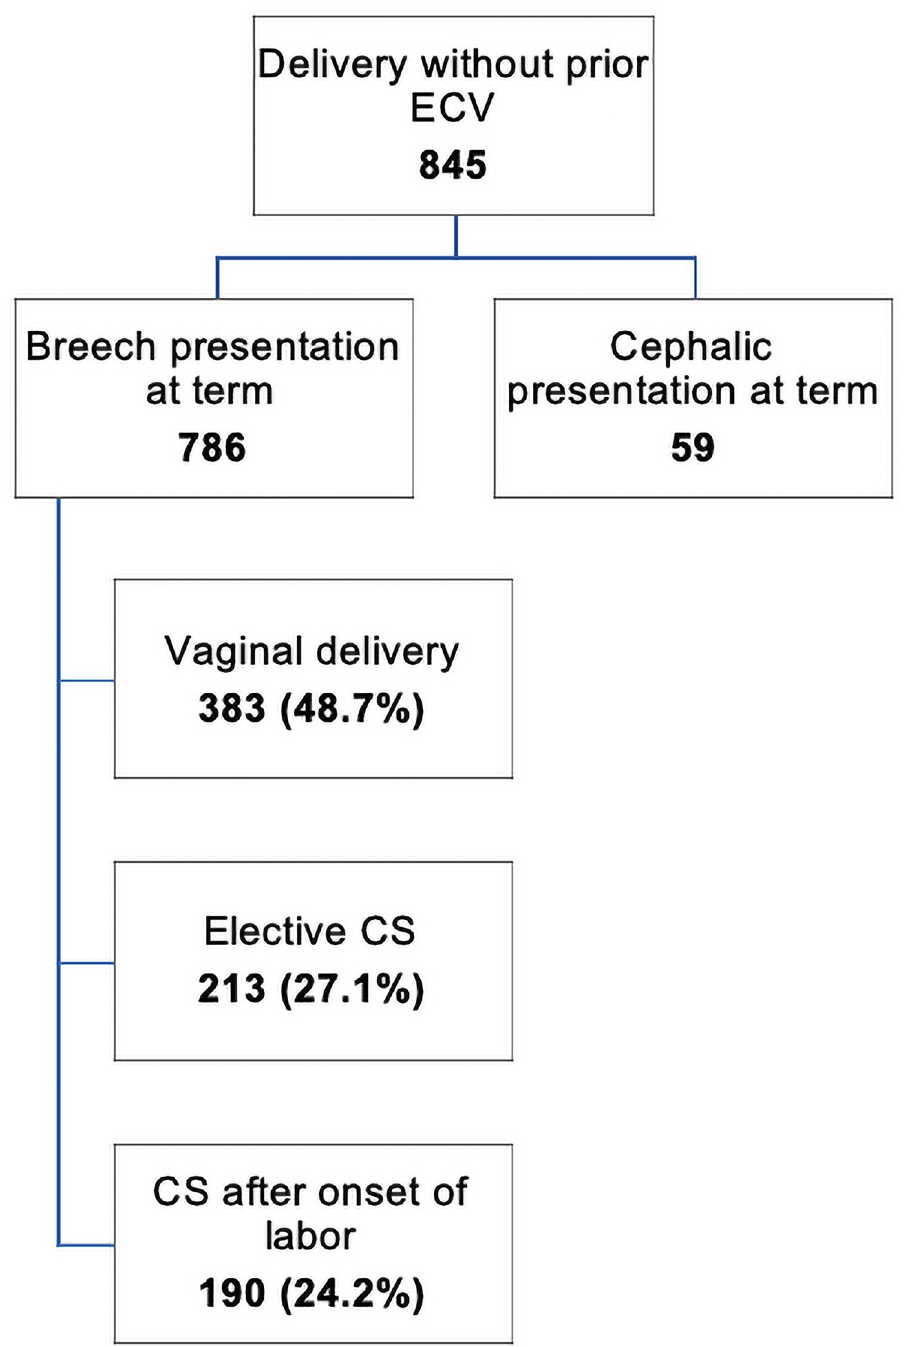
Fig 3. Flowchart showing the delivery mode of all women without prior ECV and delivered in our center.